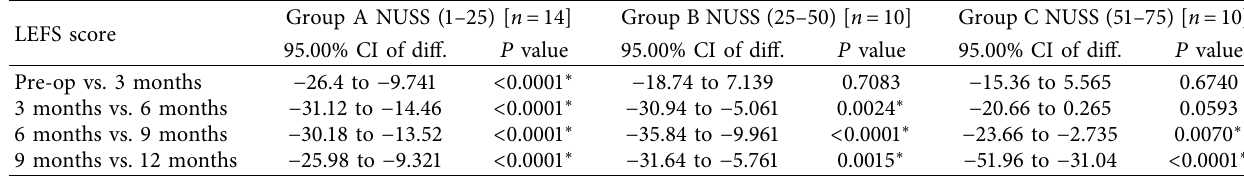
Table 3: Comparison of LEFS at serial follow-up.